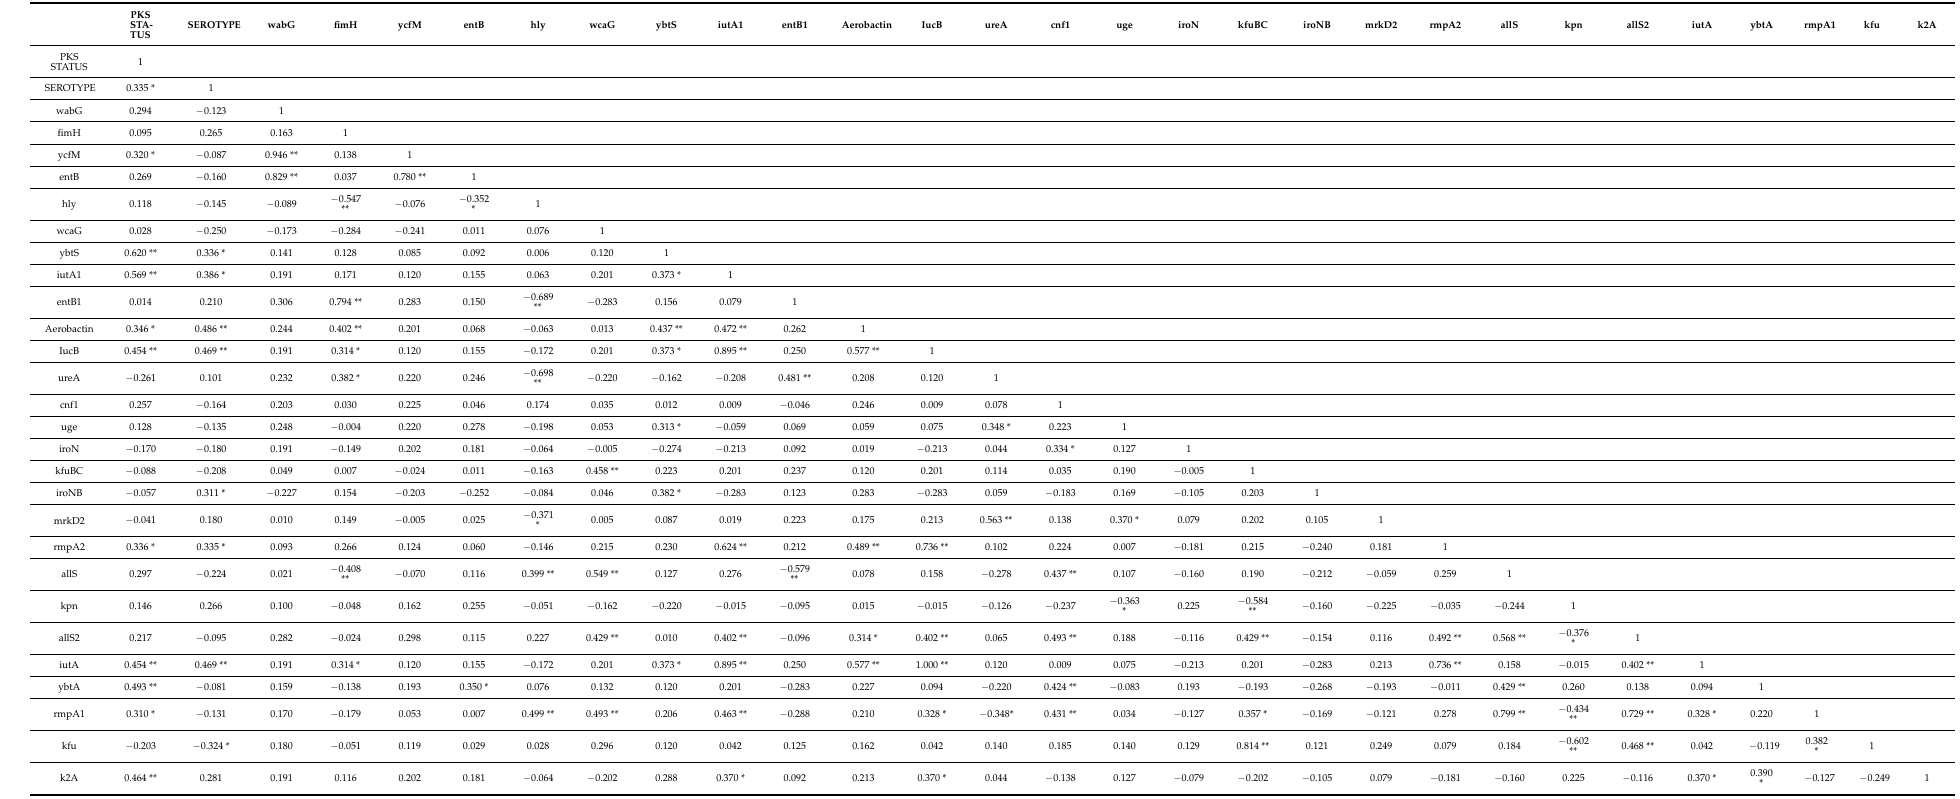
Table 3. Correlation between Pks gene and serotype against screened virulence